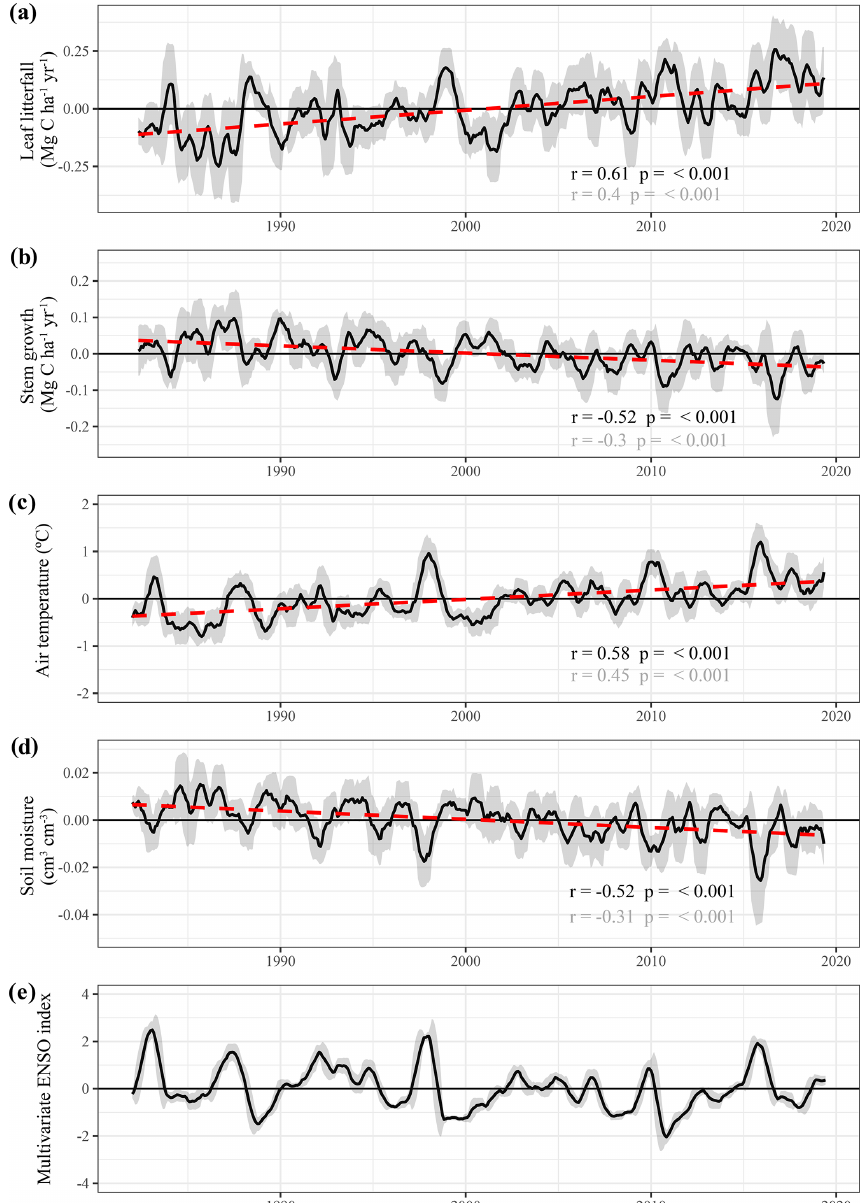
Figure 9. Long-term predictions of seasonally detrended anomalies in above-ground growth, air temperature and soil moisture across the Amazon basin and the relation with the multivariate ENSO index (Wolter and Timlin, 2011). Black lines are the 9-month moving average of the anomalies, and the dark grey uncertainty bands show the moving standard deviation of the same data. Red dashed lines represent the least-squares linear regression fit through the averaged time series. Test statistics are provided for both the linear regression of the moving average (black) and the original monthly data